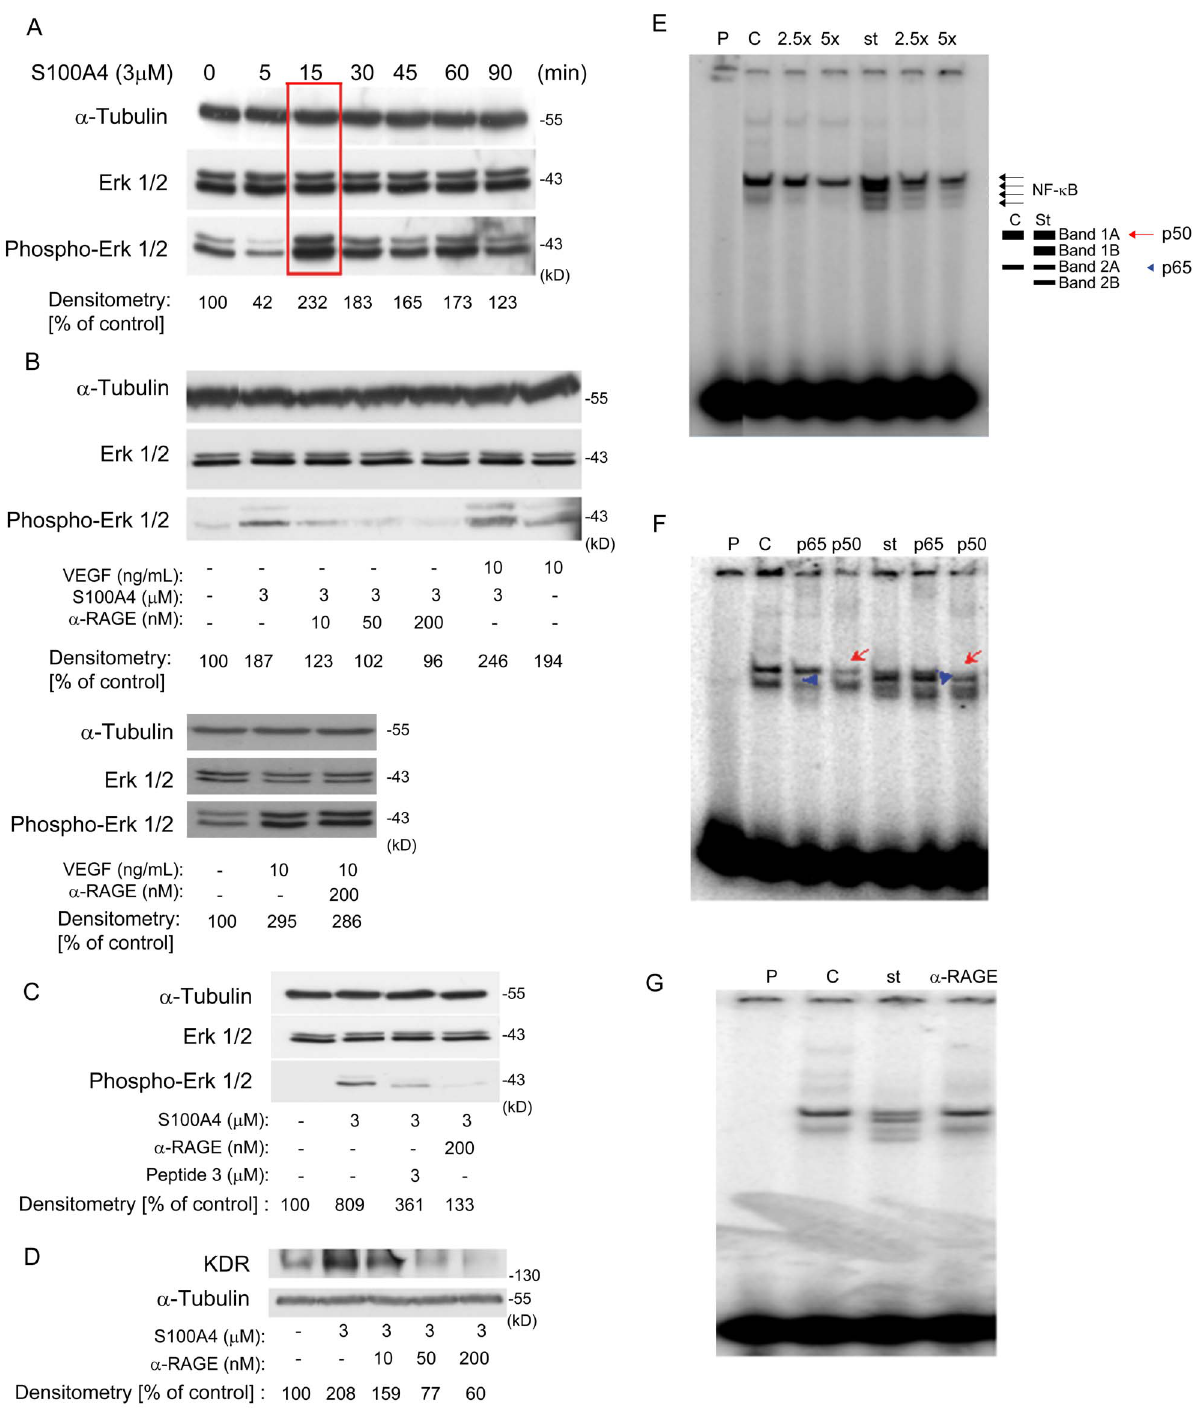
Figure 3. Extracellular S100A4 acts via RAGE in HUVECs, stimulating the ERK1/2, NF- k B signaling pathway and KDR expression. Cells were treated with the indicated proteins in EBM alone. Signal intensities were normalized to a -tubulin. A) Levels of ERK1/2 phosphorylation induced by 3 m M S100A4 for the indicated periods of time. B) Levels of ERK1/2 phosphorylation induced by S100A4 (3 m M), VEGF (10 ng/mL) and S100A4 plus VEGF for 15 min. Levels of ERK1/2-dependent S100A4 and VEGF phosphorylation by using the anti-RAGE mAb. C) Levels of ERK1/2 phosphorylation induced by S100A4 (3 m M) for 15 min either in the absence or in the presence of P3. D) Dose-dependent effect of anti-RAGE (10– 200 nM) on S100A4-induced KDR expression. E) NF- k B binding in control cells (c) and cells treated (st) with S100A4 (3 m M) and competitions with 2.5X and 5X-fold excess of unlabelled NF- k B ds oligonucleotide. F) Supershift analysis: nuclear extracts were incubated overnight at 4 u C in the presence of anti-p50 (arrow) and anti-p65 (arrowhead) antibodies before the addition of the consensus NF- k B probe. G) Gel-shift using the consensus NF- k B probe and nuclear extracts from control HUVEC (c), cells treated (st) with S100A4 (3 m M) or with the anti-RAGE antibody (200 nM), 2 h before S100A4 stimulation.